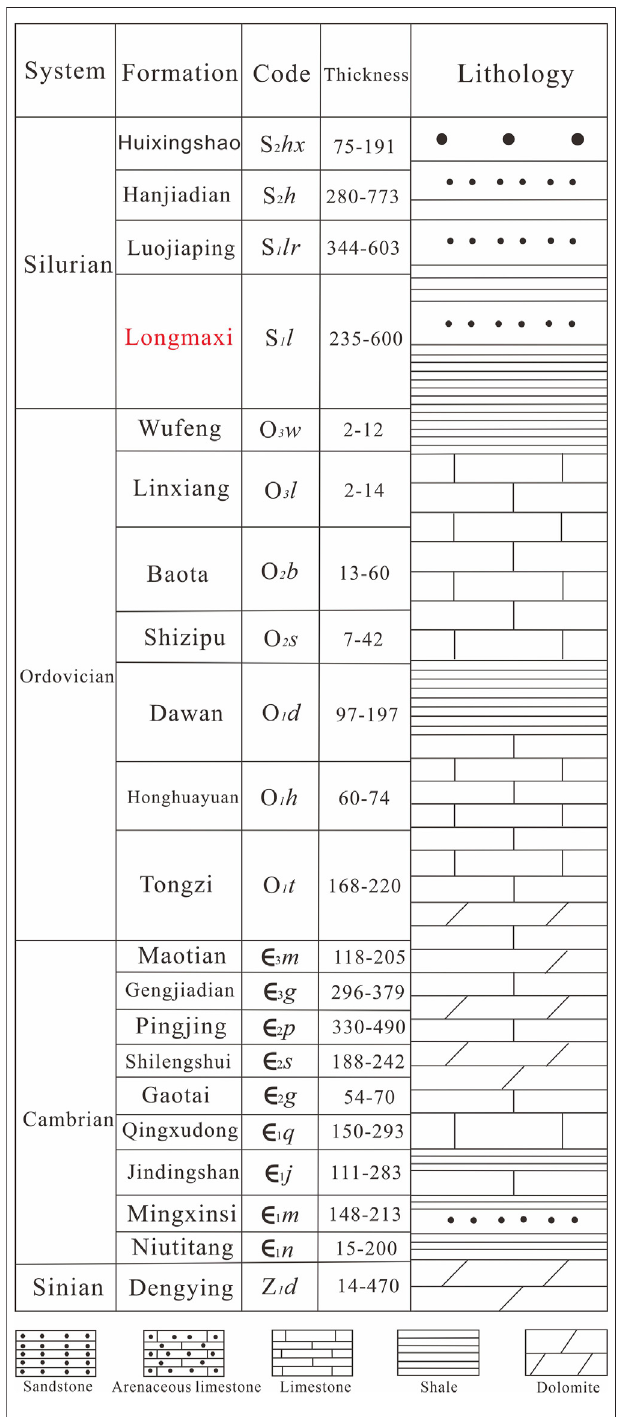
FIGURE 3 | (A) Structural plan and cross-section through southeastern Chongqing ( fi gure modi fi ed from Zhao et al., 2017). (B) Structural plan and section of northwestern Hunan ( fi gure modi fi ed from Xi et al.,